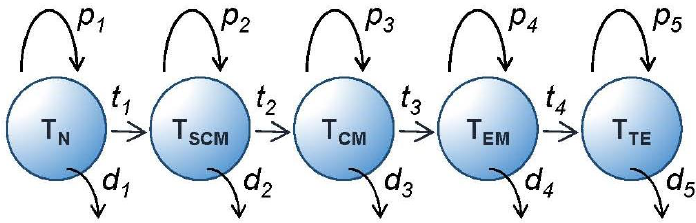
Figure 4. Kinetic model for T cell differentiation. Model of T cell memory population homeostasis. Circles represent phenotypically defined populations. Each population has a rate of intrinsic proliferation ( p ), a rate of transition to the next pool ( t ), and a rate of death ( d ). At equilibrium, all fluxes are in balance. Pool sizes are determined by the relative values of p , d and t . T RM and other populations are not shown for simplicity in this diagram.